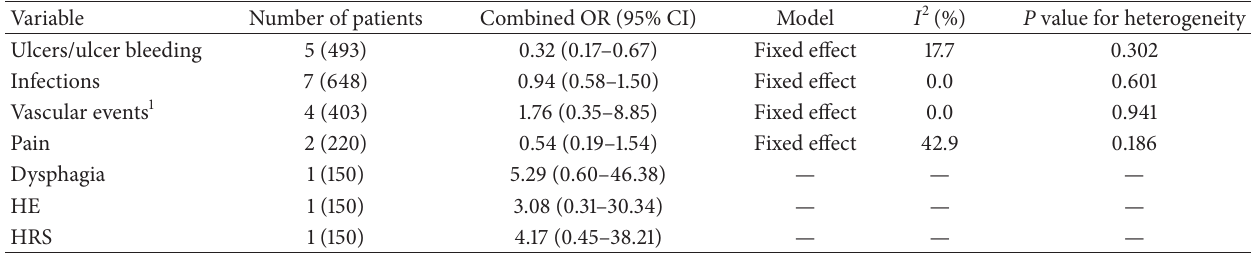
Figure 8: Comparison of the overall incidence of complications in the GVO and GVL groups. GVO, cyanoacrylate injection; GVL, band ligation; CI, confidence interval; OR, odds ratio. Table 3: Comparison of complications between GVO and